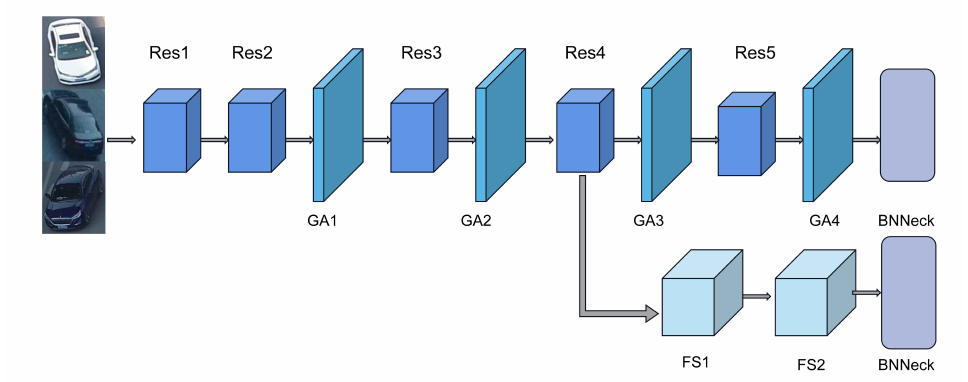
Figure 8. The overall structure of